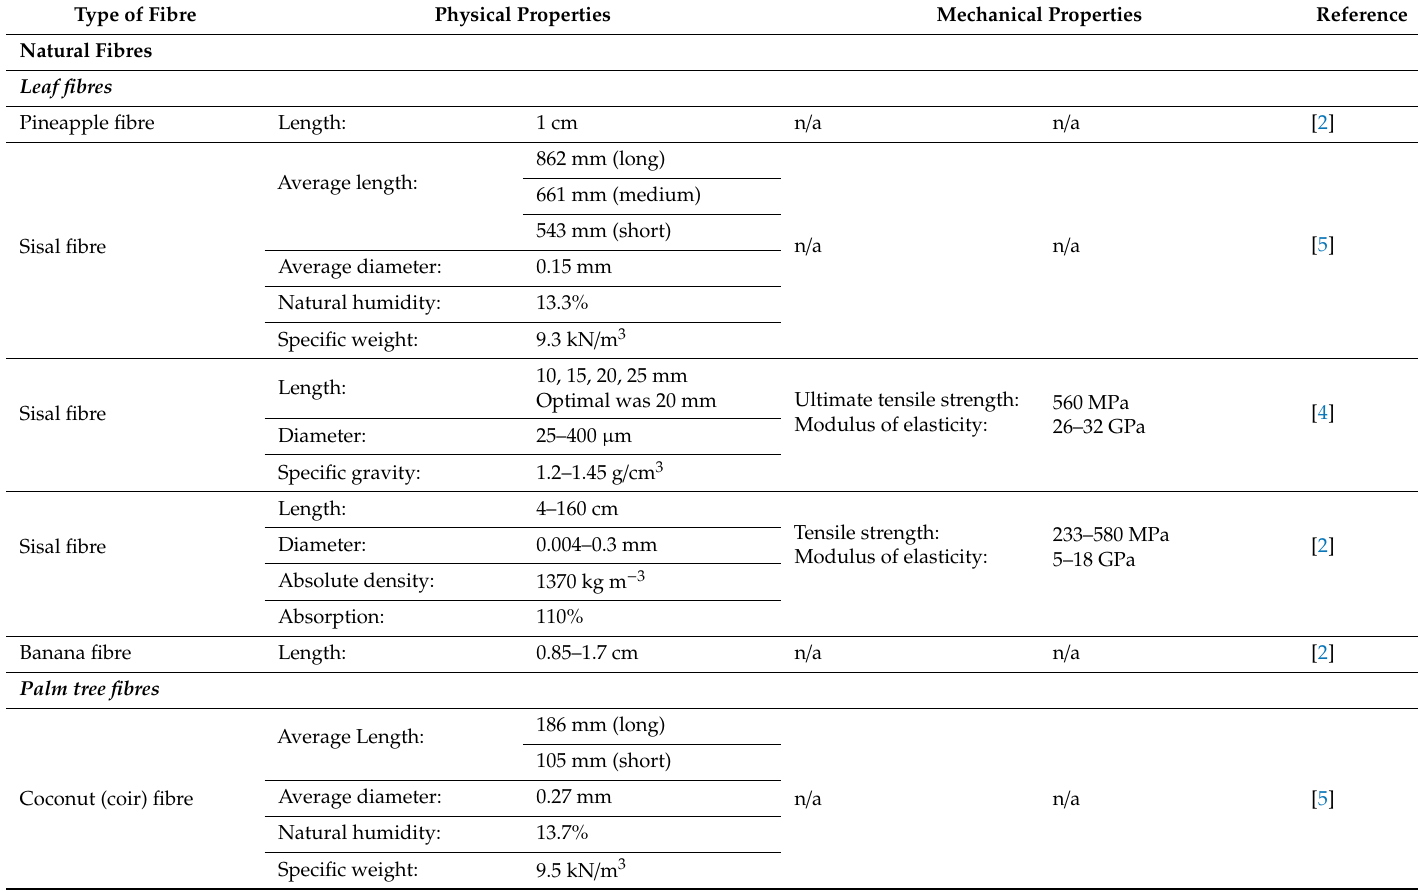
Table A1. Summary table of